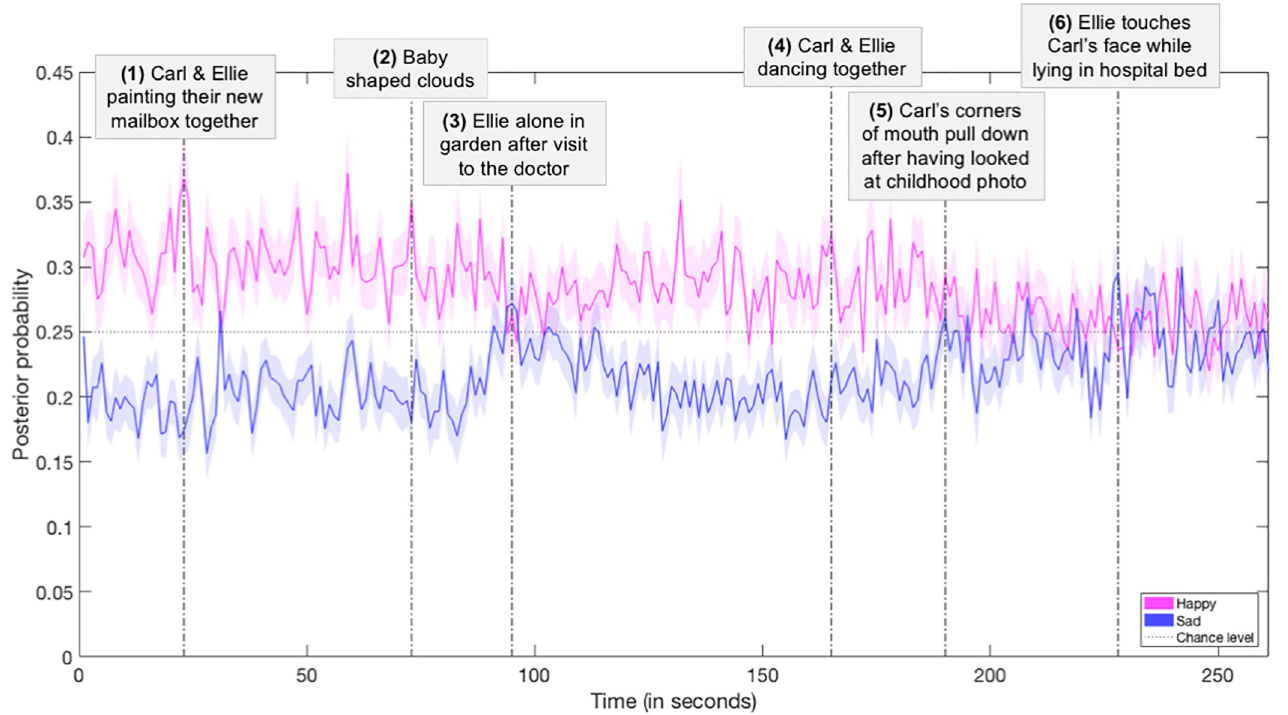
Fig 5. Dynamics of posterior probabilities for Up . Averaged across participants and 500 repetitions, with different observations used in the feature selection and classifier training stages across repetitions. The shaded areas indicate the standard deviation across repetitions. The vertical lines illustrate six examples of scenes at different moments in time, with moments (3), (5) and (6) indicating parts of the video that contain relatively more sad content. (1) Carl and Ellie just got married and are renovating the house: the posterior probabilities for a happy response are high. Once in a while they go on a picnic and look at the sky full of clouds. First, they see a cloud turn into an animal, then they see a cloud turn into a baby, and eventually at (2) all the clouds start to look like babies. (3) The sad part in de middle is elicited by the moment Ellie “gets told” in the hospital that she cannot have a baby: the posterior probabilities for a sad response rise briefly above chance level. After a short while, the couple picks up where they left off, and the distinction between the probabilities of a happy and sad response increase again. Over time, Carl and Ellie grow old and although they are still very happy with their lives together (4; Carl and Ellie dance together-scene), Carl realizes after having looked at an old photo (5) that much time has passed and their lives have not turned out the way they had hoped for. Eventually, we see Ellie in a hospital bed and at (6) she has just given back to Carl the book in which they had saved all their planned adventures. The posterior probabilities of a sad response rise above chance level from time to time and the happy response does not clearly dominate